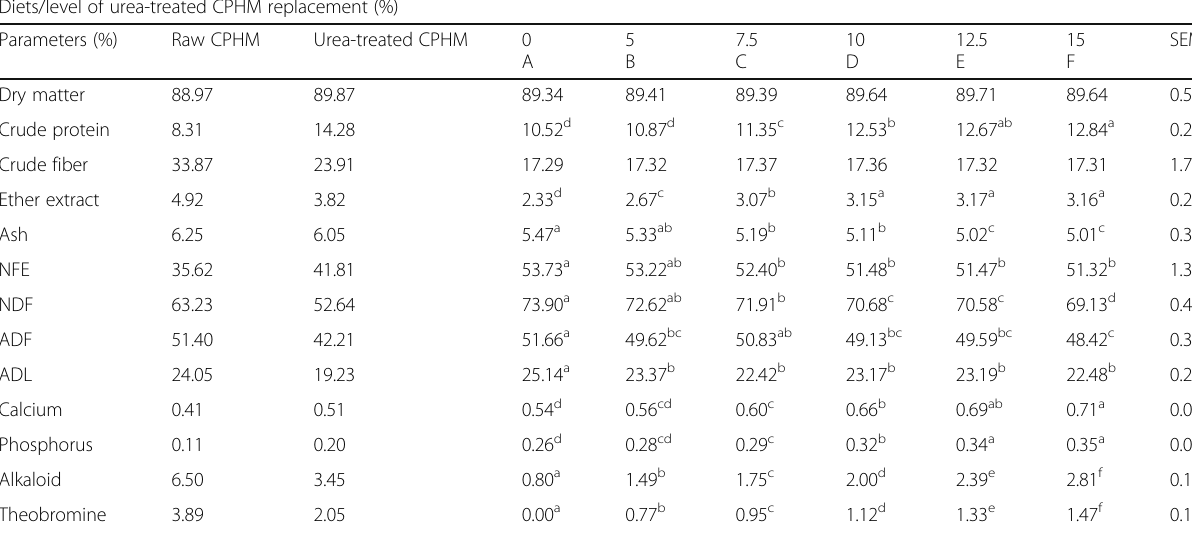
Table 2 Chemical composition of raw, urea-treated ensiled cocoa pod husk and formulated diets Diets/level of urea-treated CPHM replacement (%) Parameters (%) Raw CPHM